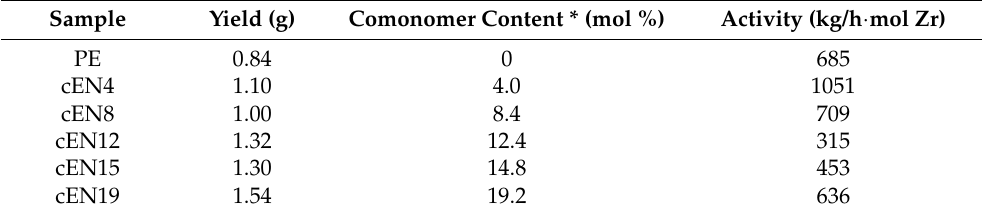
Table 3. Yields, comonomer content and activity for the resultant materials.